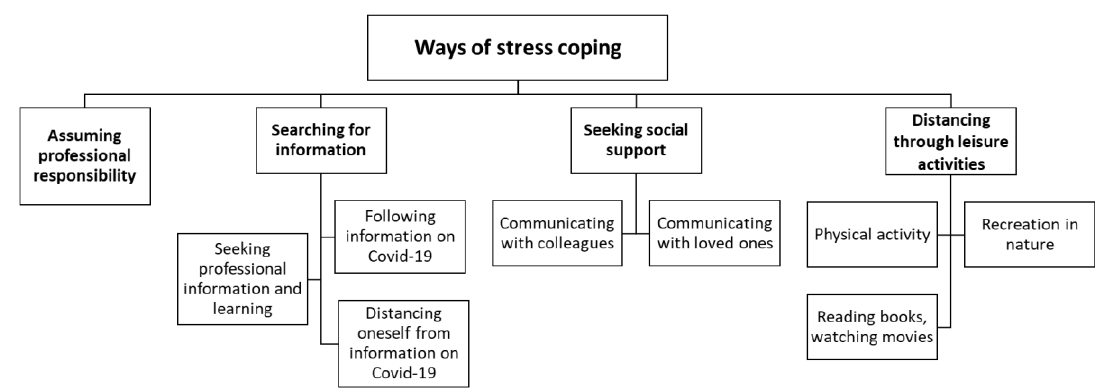
Figure 1. Stress coping among healthcare and pharmacy specialists: thematic analysis.